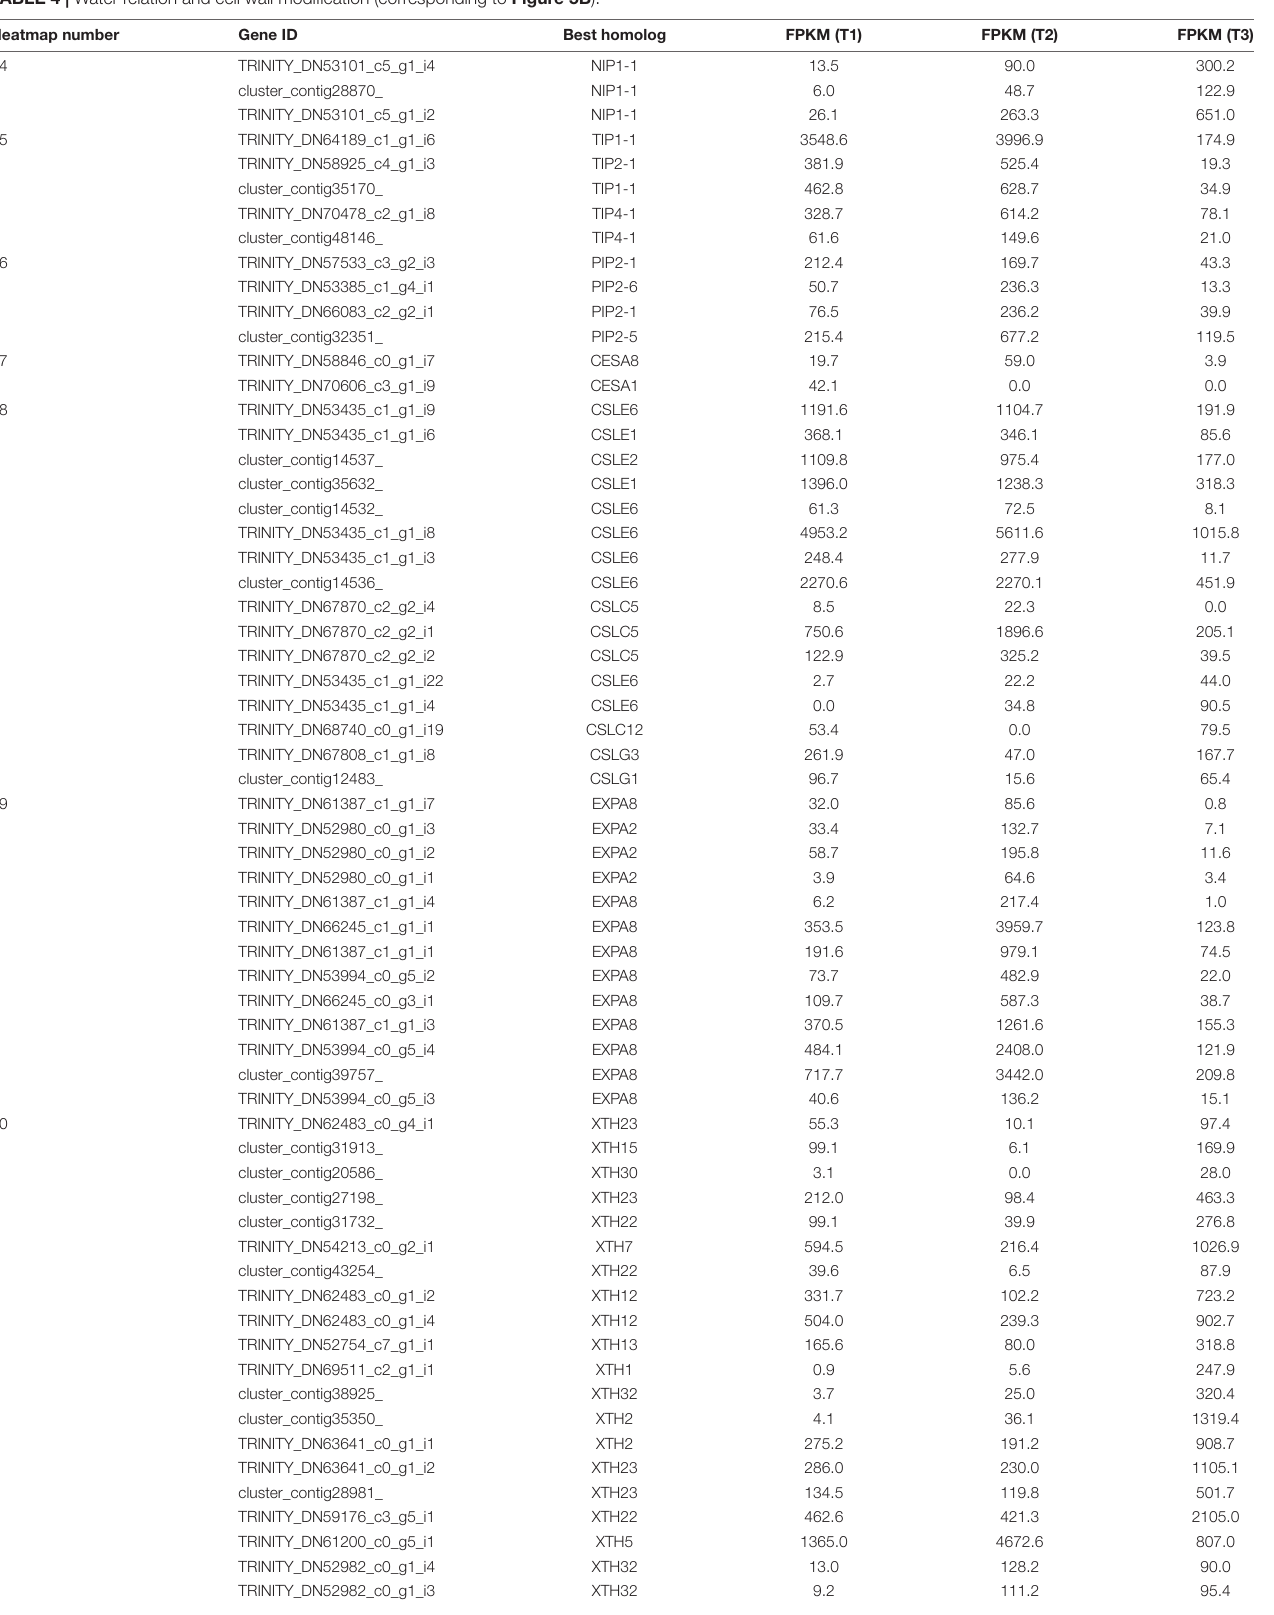
TABLE 4 | Water relation and cell wall modification (corresponding to Figure 5B